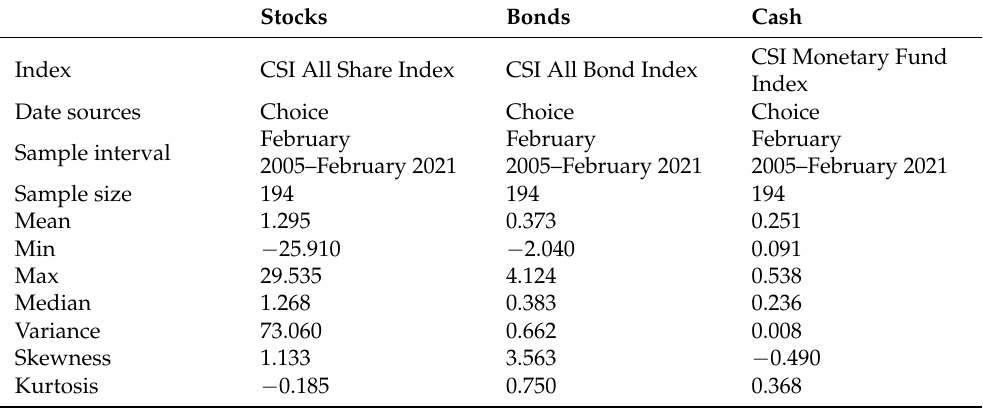
Table 1. The descriptive statistical results of historical returns data of three types of